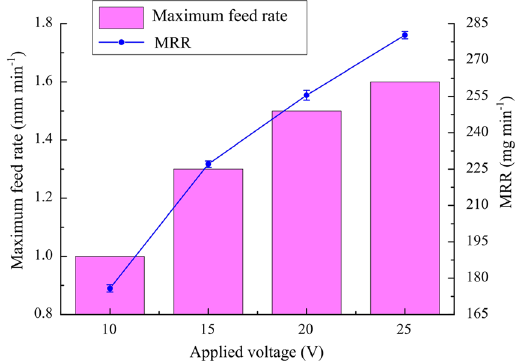
Figure 9. Variations of maximum feed rate and MRR with applied voltage.